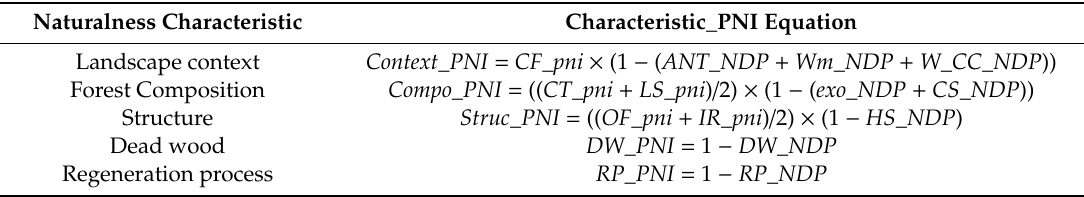
Table 1. Partial naturalness index equations for each naturalness characteristic (characteristic_PNI) (source: